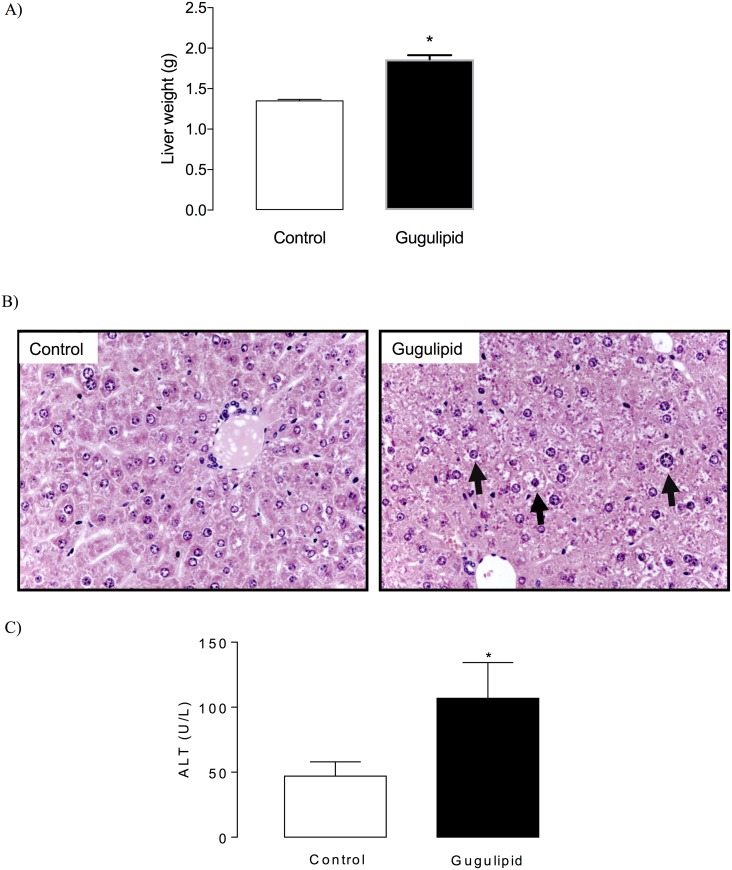
Effect of gugulipid on liver weight and histology and alanine transferase (ALT) level in male C57BL/6 mice.(A) Liver weight, (B) hepatic histology, and (C) plasma ALT level in control and gugulipid-treated mice. Arrows in (B) indicate enlarged hepatocytes with cytoplasmic tumefaction and vacuolization. Two independent experimental sets were used; n = 6 in each set. Values represent mean ± SD. *P<0.05.